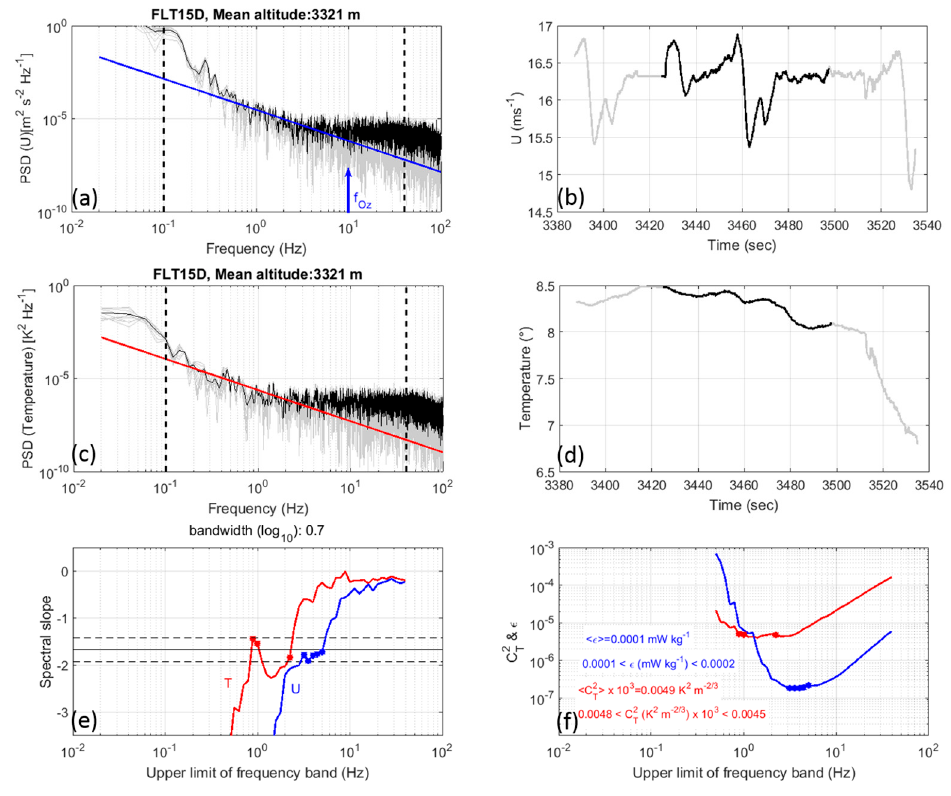
Figure 3. The same as Figure 2 for a “Weak turbulence” case during FLT15D around 3321 m altitude.